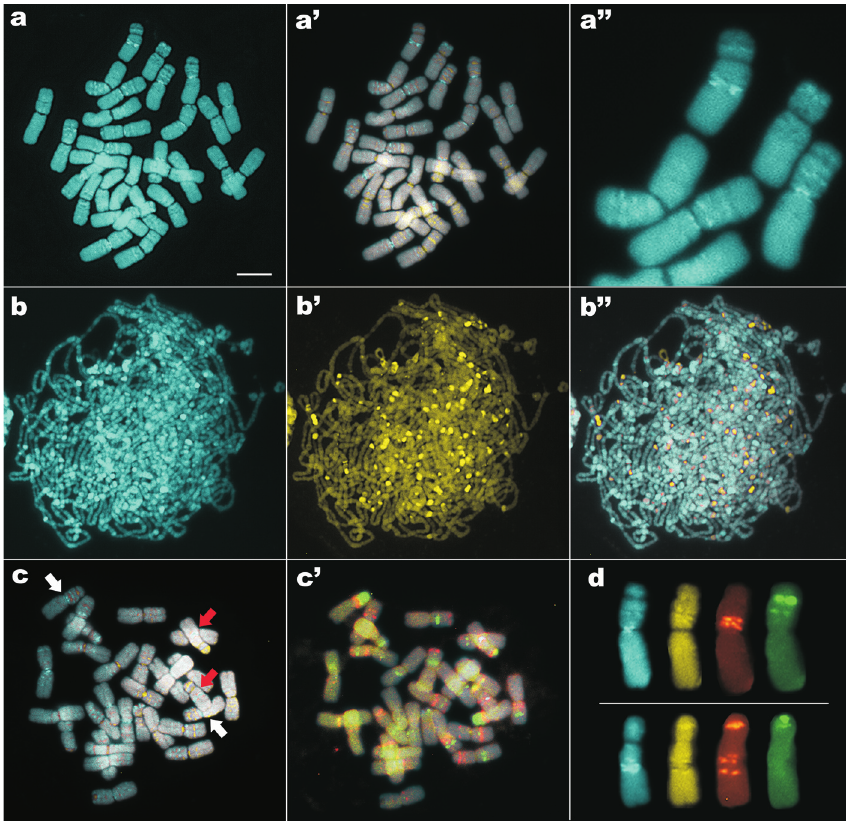
Figure 2 - CMA/DAPI bands and rDNA sites in Cuscuta monogyna . (a-a”) Metaphase showing DAPI bands (a), DAPI and CMA merged images (a) and enlarged images of some chromosomes with several DAPI bands (a”). (b-b”) Zygotene stained with DAPI (b), CMA (b’) and merged images (b”). (c, c’) Metaphase showing CMA and DAPI bands (c) and rDNA sites (c’). White and red arrows indicate the chromosome pairs bearing, respectively, the first and the second largest pairs of 35S rDNA sites. (d) First (upper row) and second (lower row) largest pairs of satellited chromosomes from another metaphase showing heterochromatic bands and rDNA sites. Observe that the centromere in the metacentric pair was DAPI + /CMA - whereas in the other pairitwasnegativeforDAPIandundifferentiatedforCMA.Blue=DAPI;yellow=CMA;orange=5SrDNA;green=35SrDNA.Barin(a)corresponds to 10 (cid:3) m (not valid for a” and